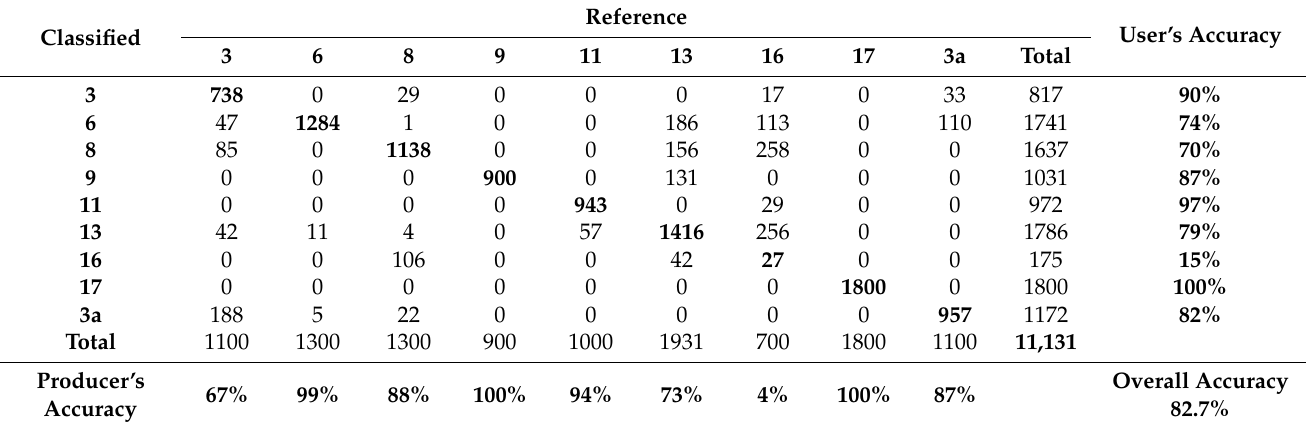
Table 7. Thohoyandou confusion matrix for multitemporal